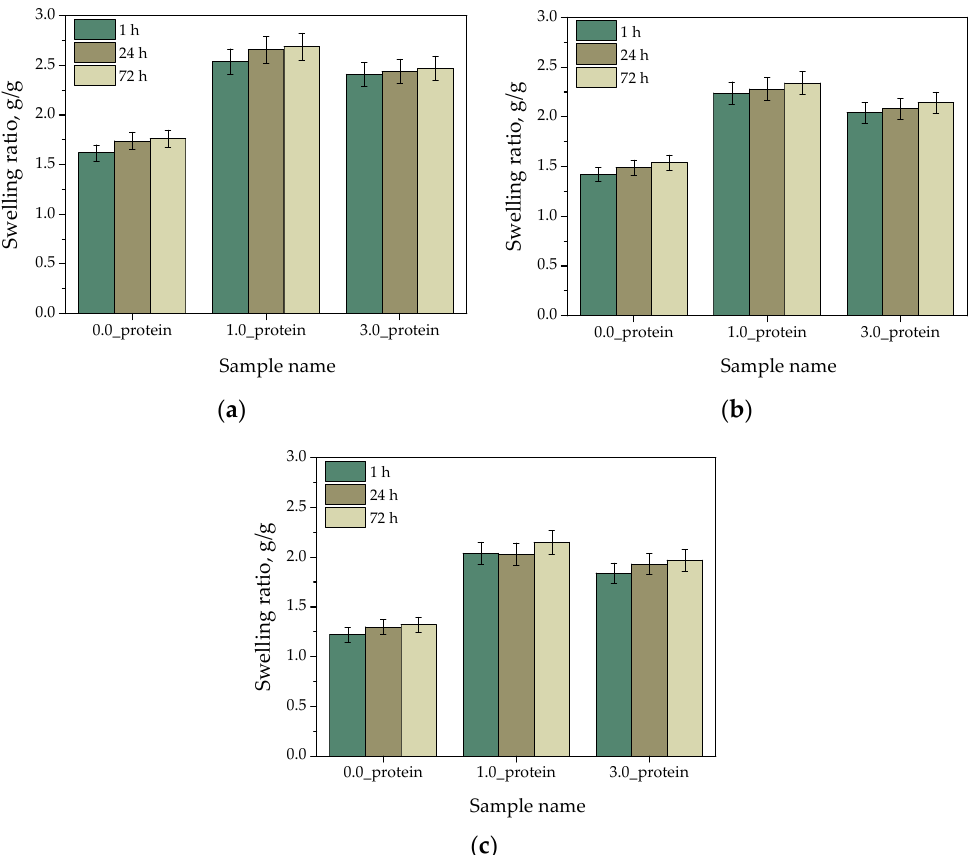
Figure 4. Results of swelling studies in distilled water ( a ), Ringer liquid ( b ) and SBF ( c ) ( n —number of repetitions, n = 3). of repetitions, n =